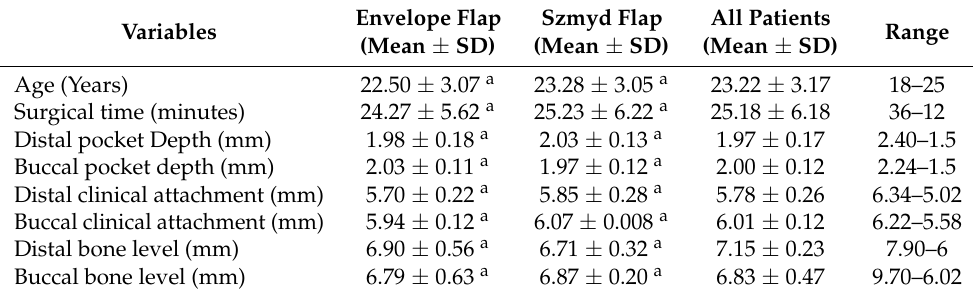
Table 2. Characteristics of patients at baseline.